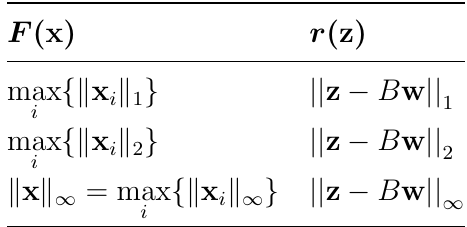
Algorithm 4.1 Threshold monitoring